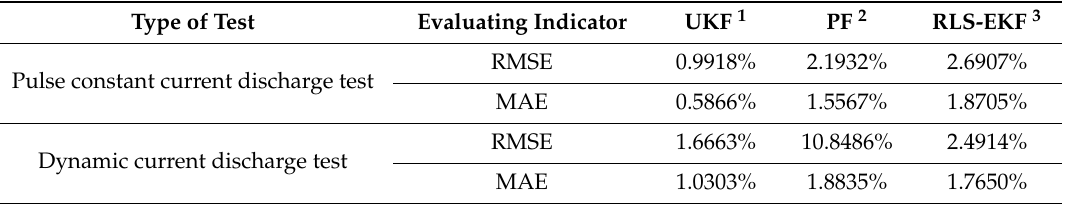
Figure 9. Comparison of different SOC estimation methods. ( a ) Comparison of SOC estimation results of the pulse constant current discharge test. ( b ) The SOC estimation errors of the pulse constant current discharge test. ( c ) Comparison of SOC estimation results of the dynamic discharge test. ( d ) The SOC estimation errors of the dynamic discharge test. Table 3. Comparison of SOC estimation error for different estimation methods.